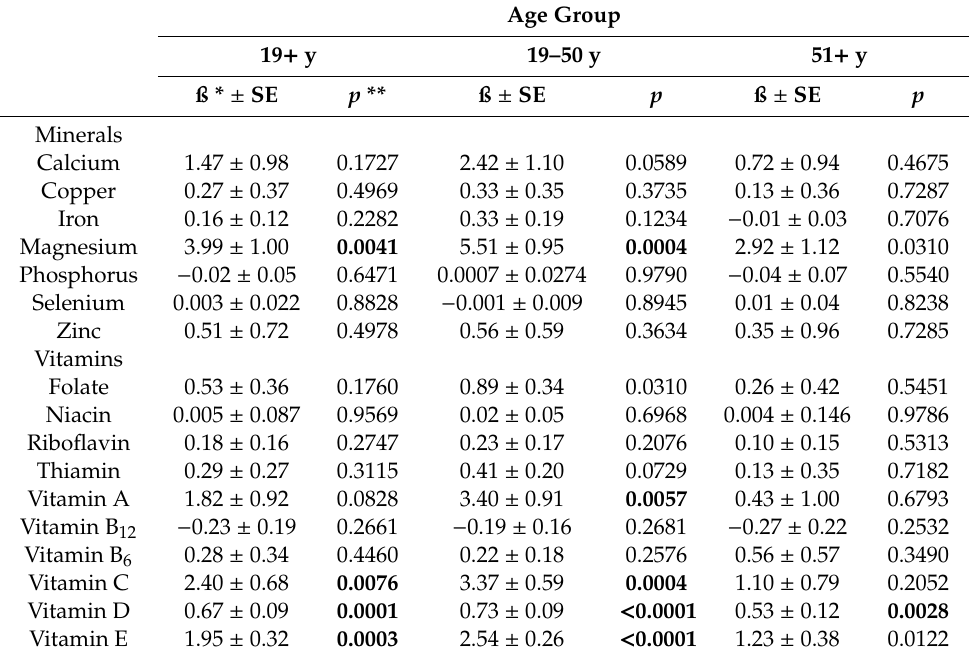
Table 2. Association between added sugars intake (% of calories) and percentage of adults 19 + y (NHANES 2009–2014) with micronutrient intakes below the EAR 1